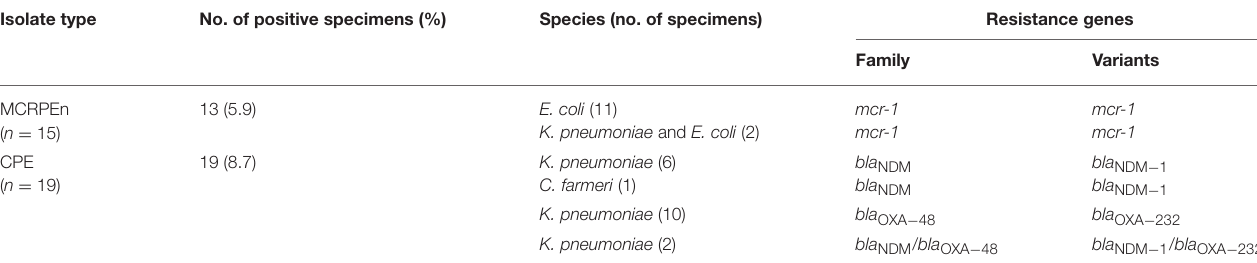
TABLE 1 | Bacterial species and the mcr-1 /carbapenemsae genes of MCRPEn and CPE isolated from 219 rectal swab specimens. Isolate type No. of positive specimens